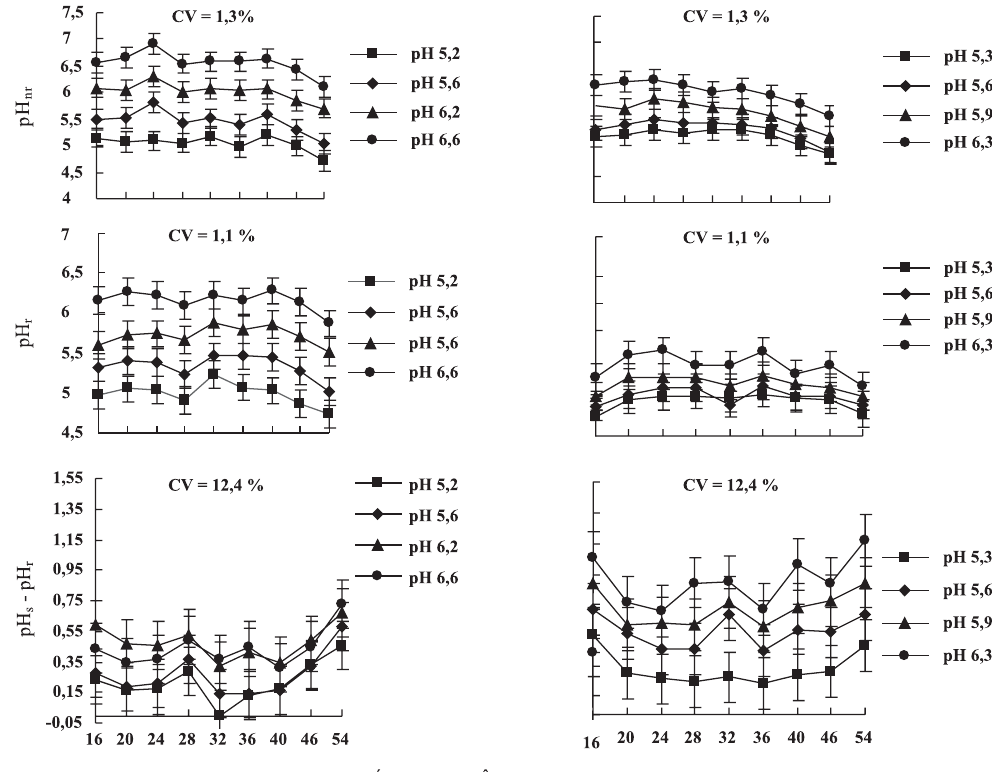
Figura 1. Efeito do pH inicial do solo argiloso e solo arenoso no pH rizosférico (pH raízes - não rizosférico (pH amostragem após a emergência de plantas de